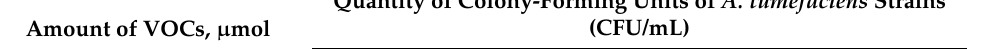
Table 1. Effect of VOCs on A. tumefaciens strain growth.